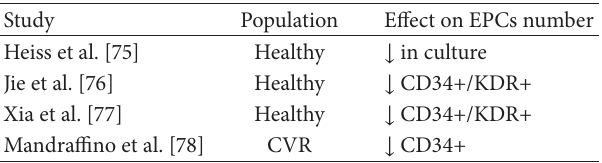
Table 4: Dyslipidemia and EPCs. Table 5: Aging and